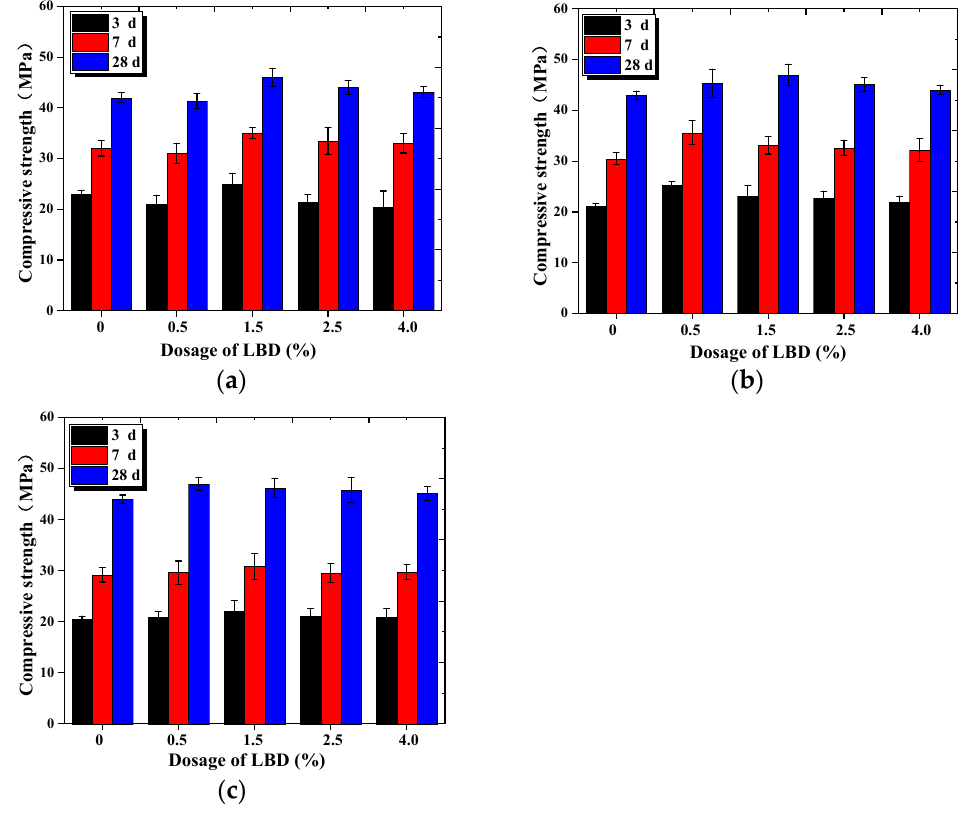
Figure 5. Compressive strength of LBD/OPC samples: ( a ) A-LBD/OPC samples; ( b ) B-LBD/OPC samples; ( c ) C-LBD/OPC samples.